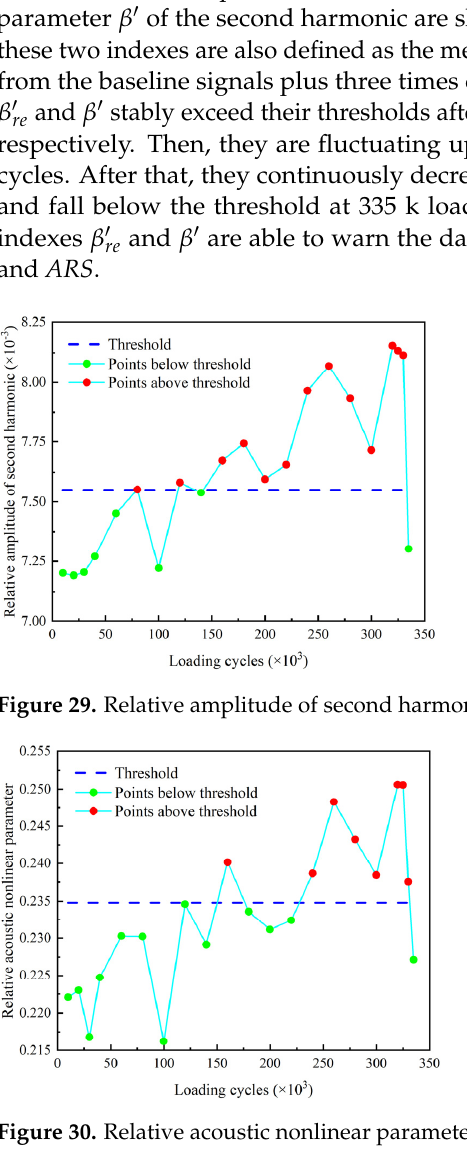
( b ) Figure 31. Frequency spectrums after various loading cycles corresponding to 10-cycle excitation. ( a ) Fundamental frequency spectrums around central frequency; ( b ) Second-order frequency spec- trums around double of central frequency. The nonlinear indexes 𝛽 (cid:3045)(cid:3032)(cid:4593) and 𝛽 (cid:4593) corresponding to the second harmonic corre- sponding to the 10-cycle excitation signal are shown in Figures 32 and 33. Comparing Figures 32 and 33 with Figures 29 and 30, respectively, it is notable that the variation trends of 𝛽 (cid:3045)(cid:3032)(cid:4593) and 𝛽 (cid:4593) under the two excitation signals with different number of